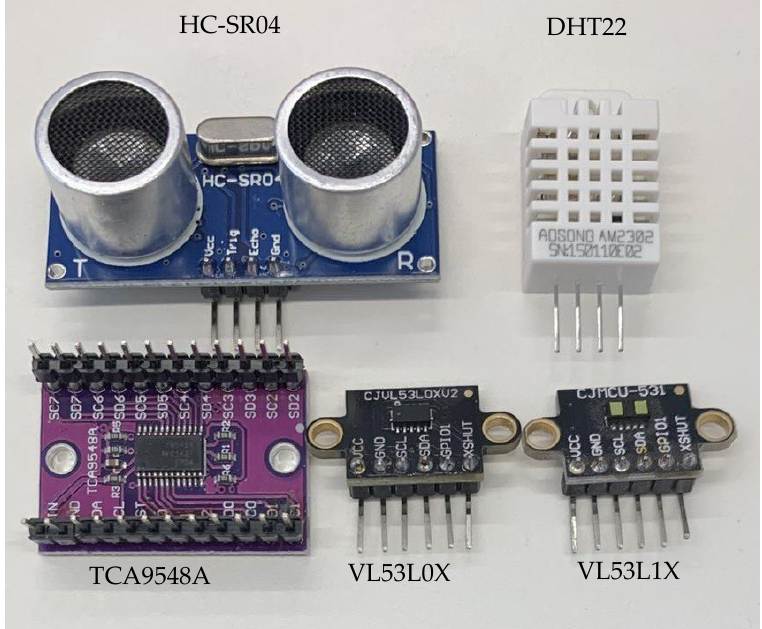
Figure 4. The used low-cost sensors of the project: HC-SR04 (ultrasonic sensor), DHT22 (temperature and humidity sensor for calibrating the ultrasonic sensor), TCA9548A (multiplexor), VL53L0X (ToF sensor), and VL53L1X (ToF